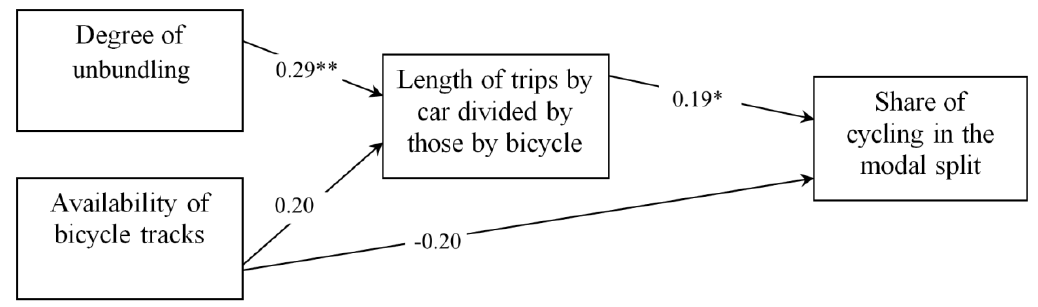
Figure 3. Structural model with standardized parameter estimates (*p <.05. **p <.01;